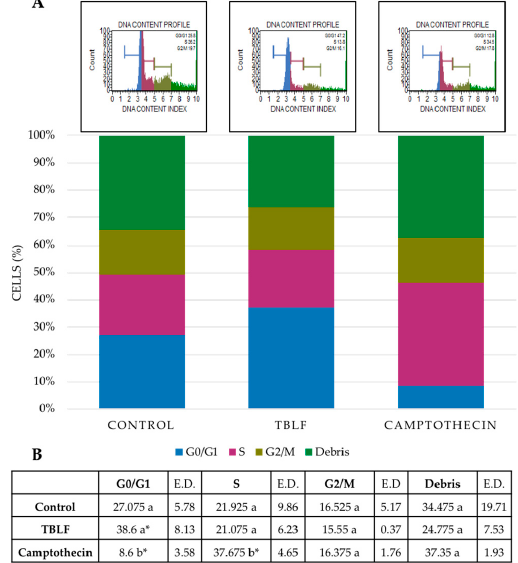
Figure 4. Effect of TBLF on cell cycle arrest on HT-29 colon cancer cells. Cells were treated with the TBLF-LC 50 for 8 h. ( A ) Representative results of the cell cycle analysis; control group (BSA 0.5%), TBLF-LC 50 and positive control camptothecin (5 µ M). ( B ) Graphic results obtained in the cell cycle analysis. One-way ANOVA was performed for each cell cycle phase. Small letters indicate significant di ff erences (Tukey p ≤ 0.05). (*) Indicates significant di ff erence (Dunnett p ≤ 0.05) with respect to the negative control